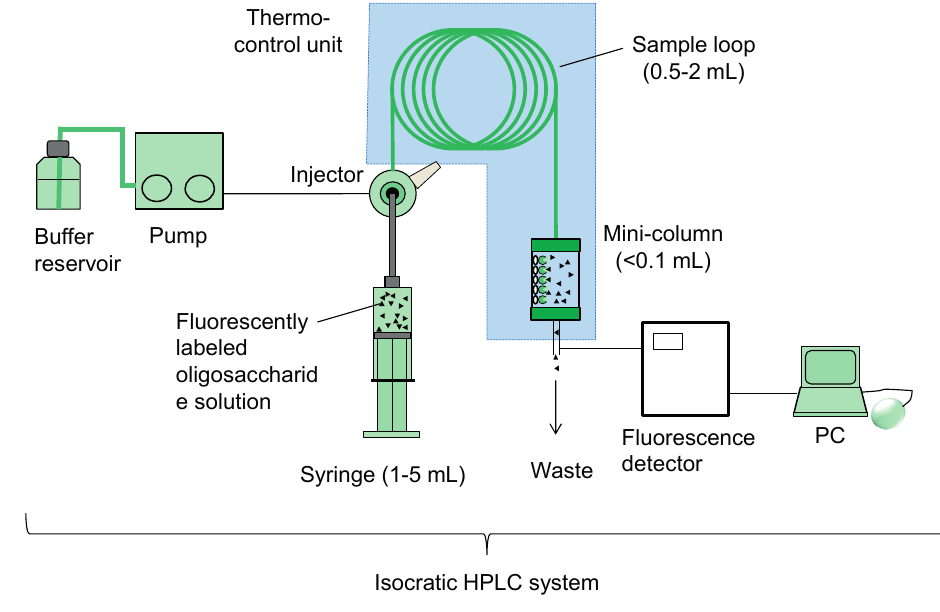
Figure 3. Fabrication of a basic FAC system. A conventional HPLC system can be used for FAC analysis, whereas a large sample loop (0.5–2 mL) relative to a column (0.1 mL or smaller) is